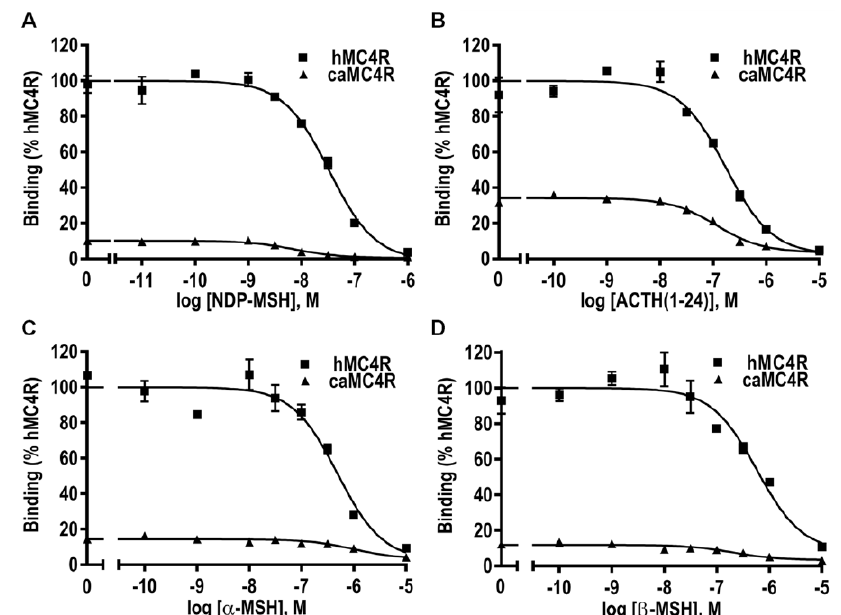
Figure 7. Ligand binding properties of caMC4R. HEK293T cells were transiently transfected with MC4R plasmids, and the binding properties were measured 48 h later by displacing the binding of 125 I-NDP-MSH using different concentrations of unlabeled NDP-MSH ( A ), ACTH (1–24) ( B ), α -MSH ( C ), or β -MSH ( D ) as described in Materials and Methods. Data were expressed as % of hMC4R binding ± range in the absence of competitor from duplicate measurements within one experiment.